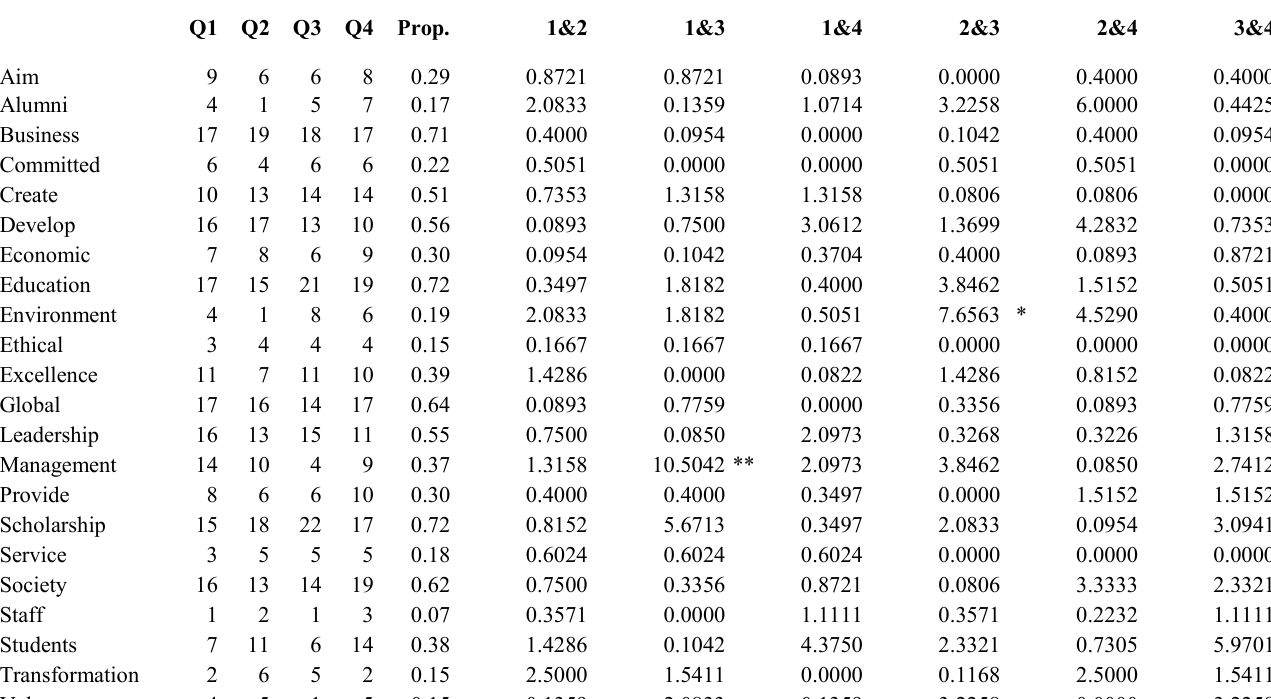
Table 3: Leximancer™ aggregated concept